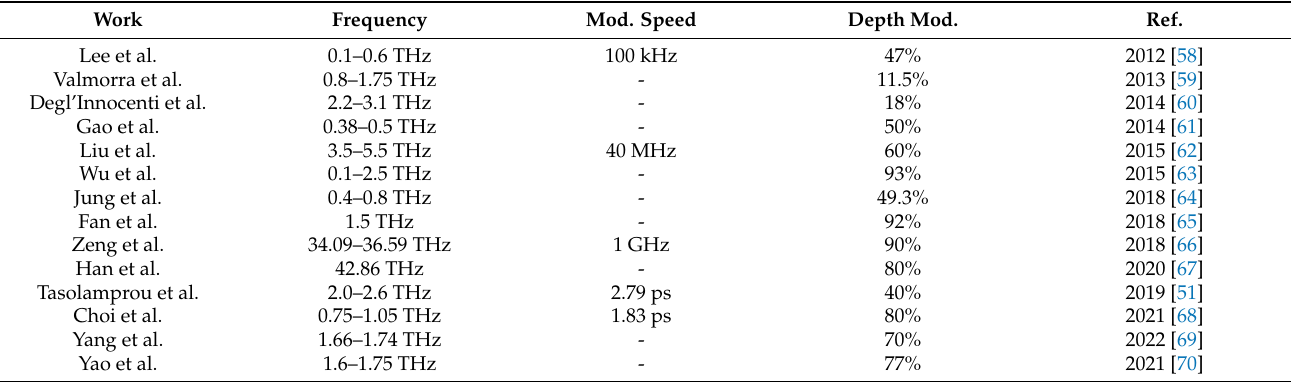
Table 1. Summary of THz amplitude